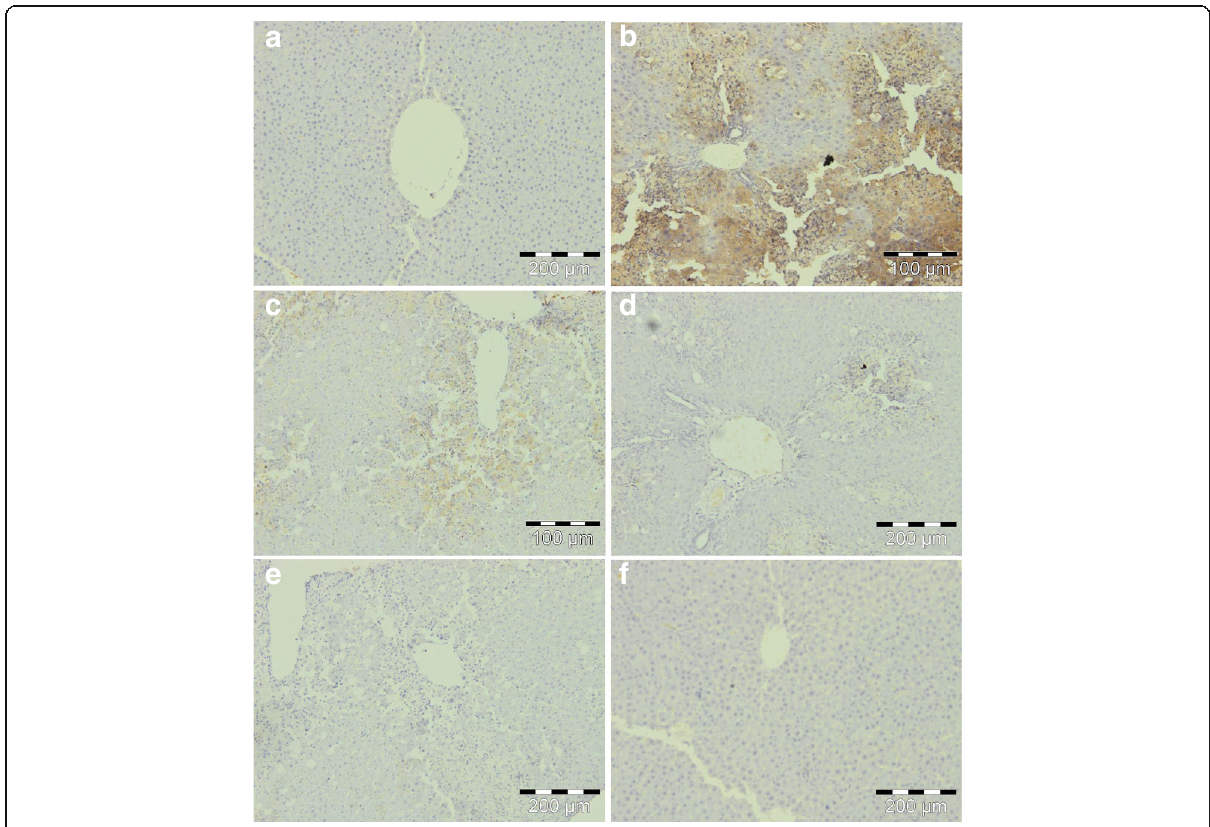
Fig. 12 Immunohistochemical appearance of PGE2. a Control group, normal. b CCl 4 (1 ml/kg b.wt.), high expression of PGE2. c C. nudiflora (150 mg/kg b.wt. + CCl 4 ), low expression of PGE2. d C. nudiflora (300 mg/kg b.wt. + CCl 4 ), low expression of PGE2. e C. nudiflora (450 mg/kg b.wt. +